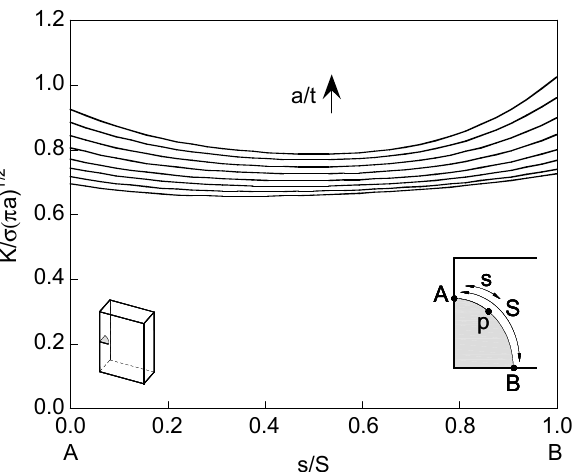
Figure 13. Dimensionless SIF along the crack front for the preferential fatigue propagation path (corrosion fatigue; cracks emanating from a plate corner).